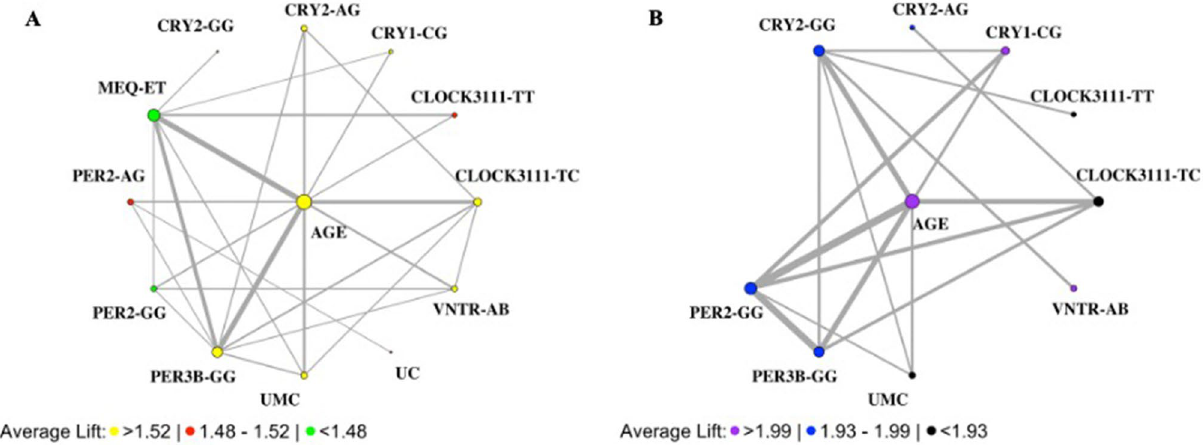
Figure 3. Association rules networks for anxiety symptoms. ( A ) In females, diurnal preference (MEQ), age, and PER3B GG co-occurred most frequently and had the highest average lift in the analysis. ( B ) In males, age, PER2 -GG, and PER3B -GG co-occurred most frequently, but combinations with CLOCK 3111TC had the highest average